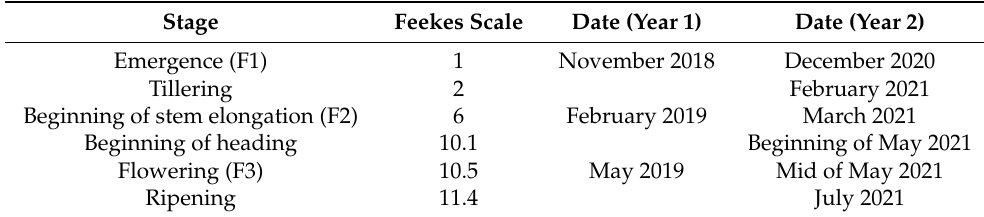
Table 1. Main phenological and developmental stages of wheat during rotations of year 1 (2018–2019) and 2 (2020–2021). F1, F2, F3 refer to the phenological temporal windows where the NDVI was evaluated in data